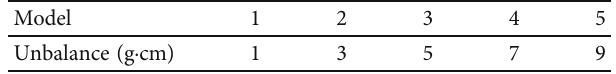
Table 7: Unbalance of PT